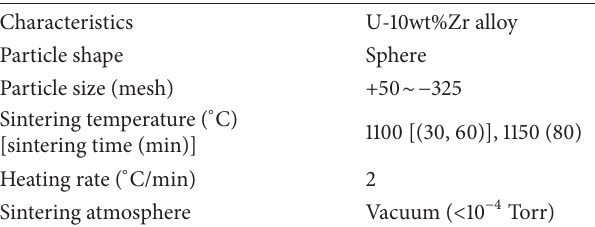
Table 1: Sintering conditions performed in this study for U-10Zr particulate metal